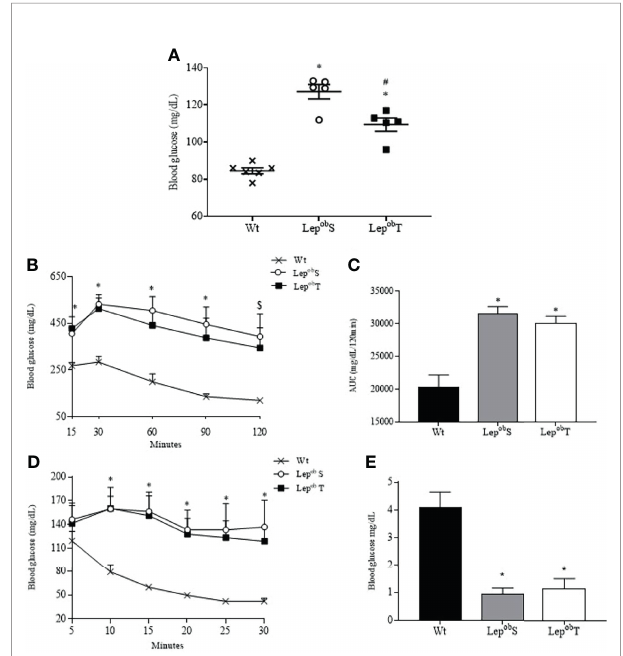
FIGURE 4 | Fasting blood glucose (A) , glucose tolerance test (B) , area under the curve (C) , insulin tolerance test (D) and kITT (E) . Wt (n = 6), Lep ob S (n = 5) and Lep ob T (n = 5). AUC = area under the curve, kITT = glucose disappearance constant rate. Error bars indicate the SEM. *p ≤ 0.05 vs. Wt, # p ≤ 0.05 vs. Lep ob S, $p ≤ 0.05 Wt vs. Lep ob S. The results were compared by the one-way ANOVA (Figure A, C and E) and by the two-way ANOVA (Figure B and D) plus Tuckey post hoc